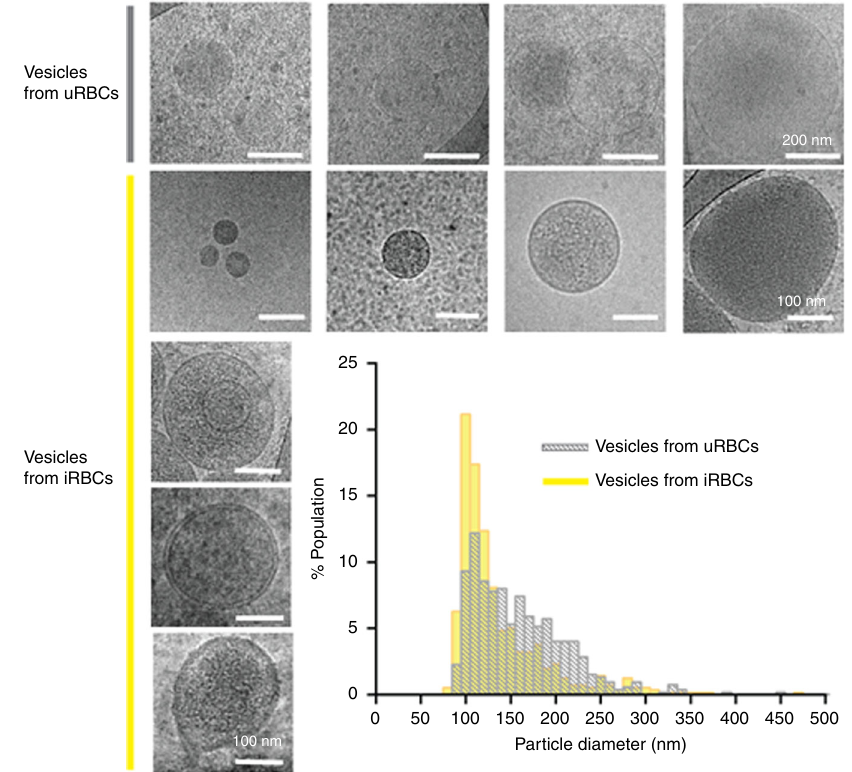
Fig. 1 Characterization of vesicles released from P. falciparum -iRBCs. Cryo-EM images and size population data of vesicles from 3D7 and CS2 lines (bottom panels, scale bar 100 nm), uRBCs (top panels, scale bar 200 nm) and a small multivesicular population of EVs with a double membrane or containing one or two vesicles in the lumen (bottom left column, scale bar 100 nm). The qNano size distribution of EVs from iRBCs and vesicles from uRBCs